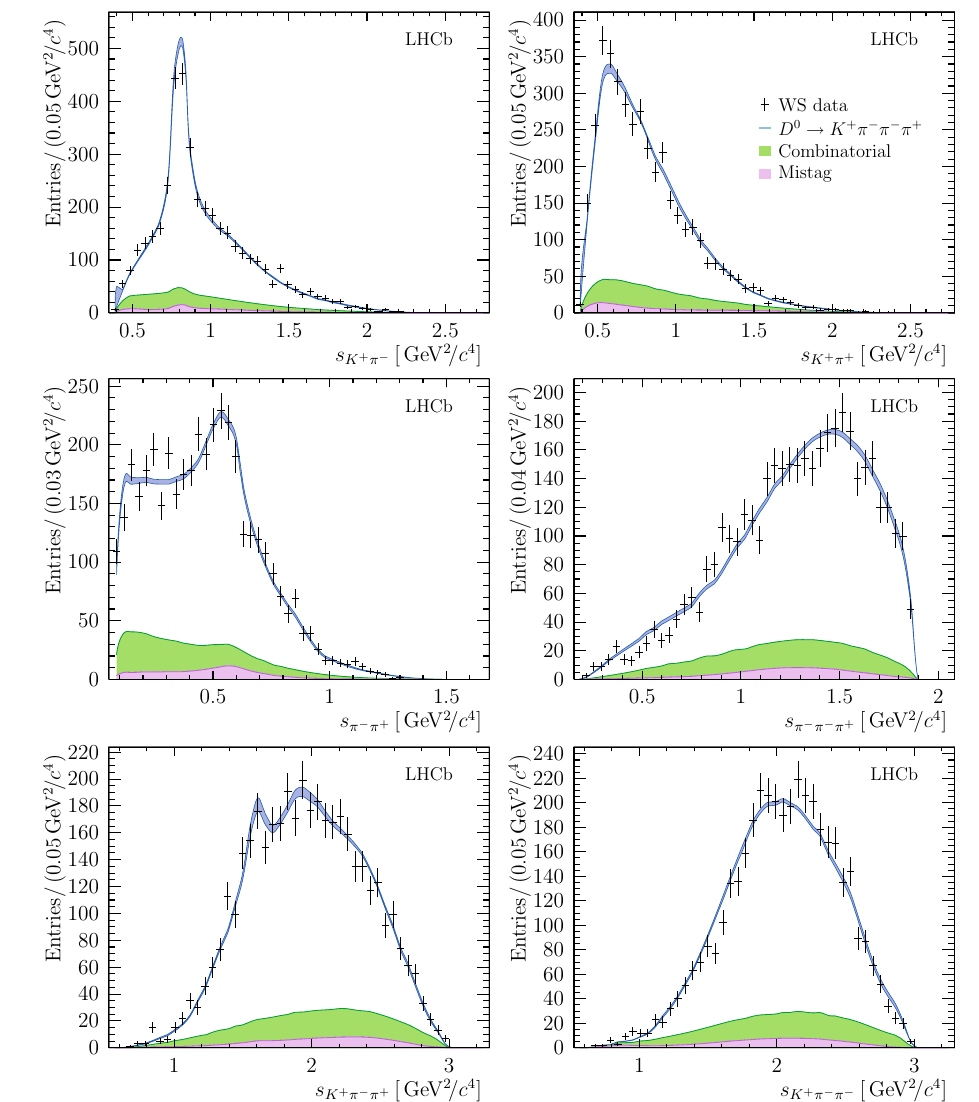
Fig. 5 Distributions for six invariant-mass observables in the WS decay D 0 → K + π − π − π + . Bands indicate the expectation from the model, with the width of the band indicating the total systematic uncer- tainty. The total background contribution is shown as a filled area, with